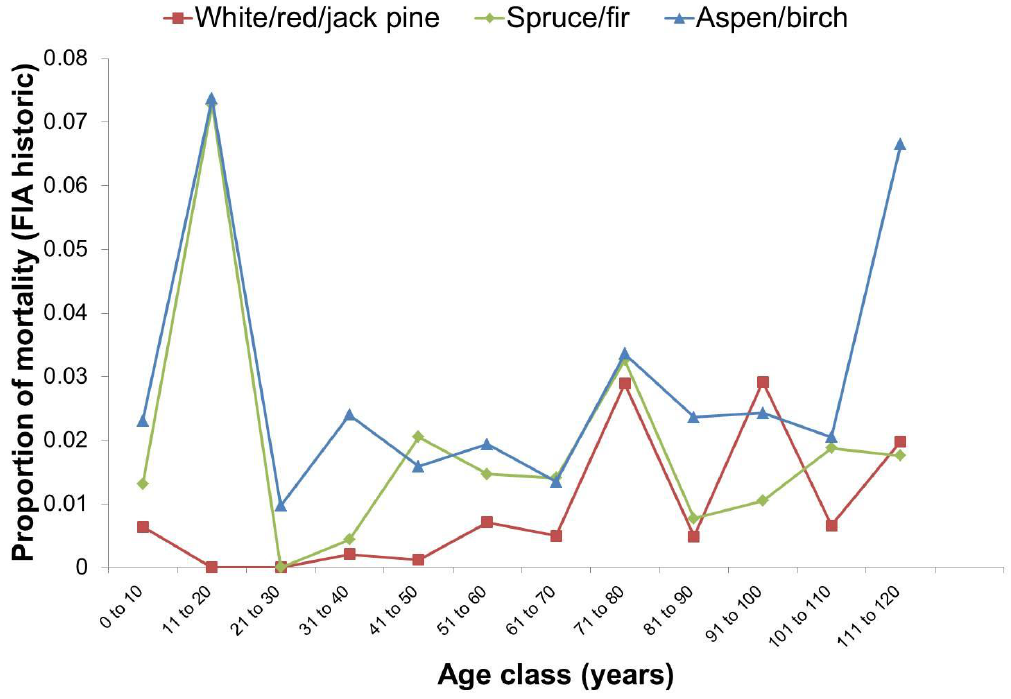
Figure 2. Current natural disturbance rates by age class for the three primary forest types used in the analysis, obtained from Forest Inventory and Analysis data from across Minnesota, USA.